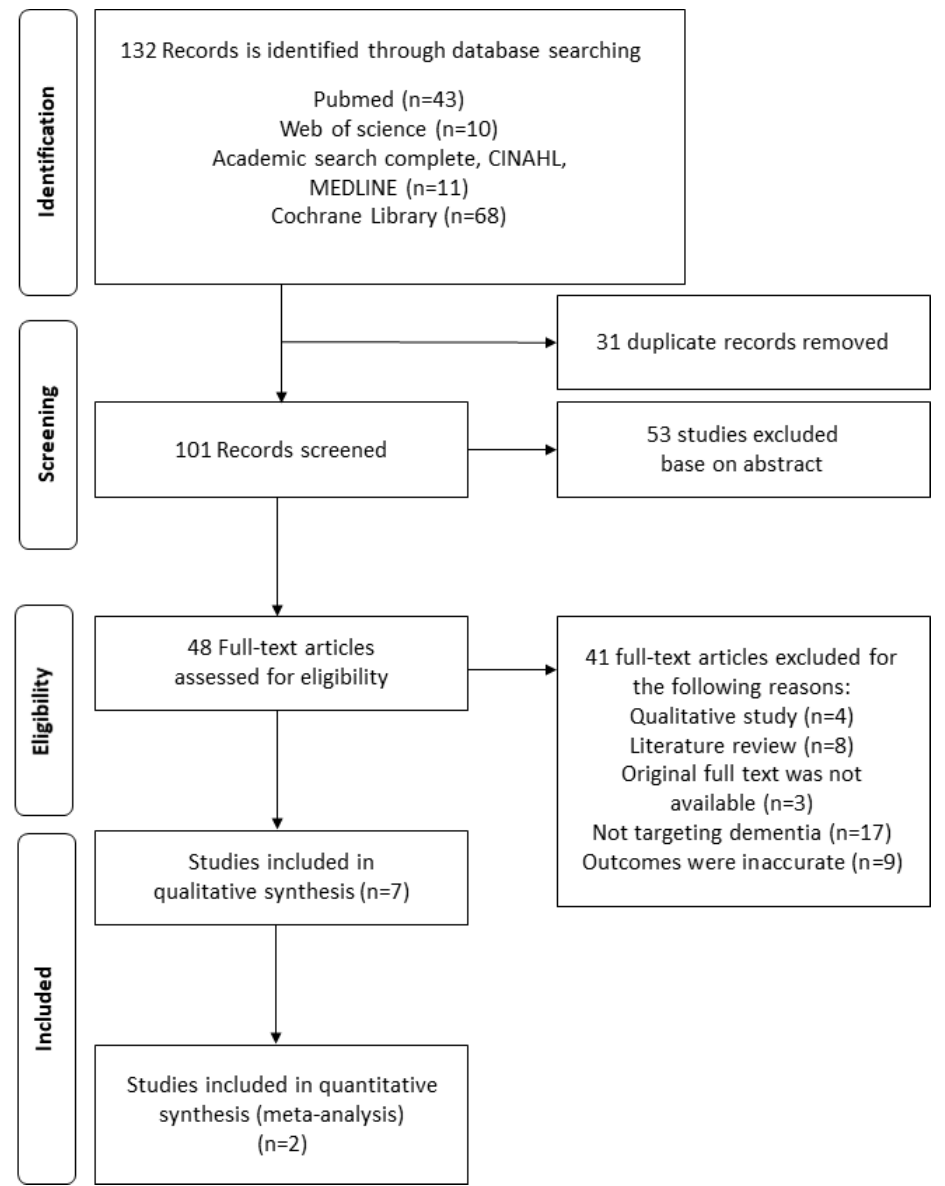
Figure 1. The flow diagram of this study.